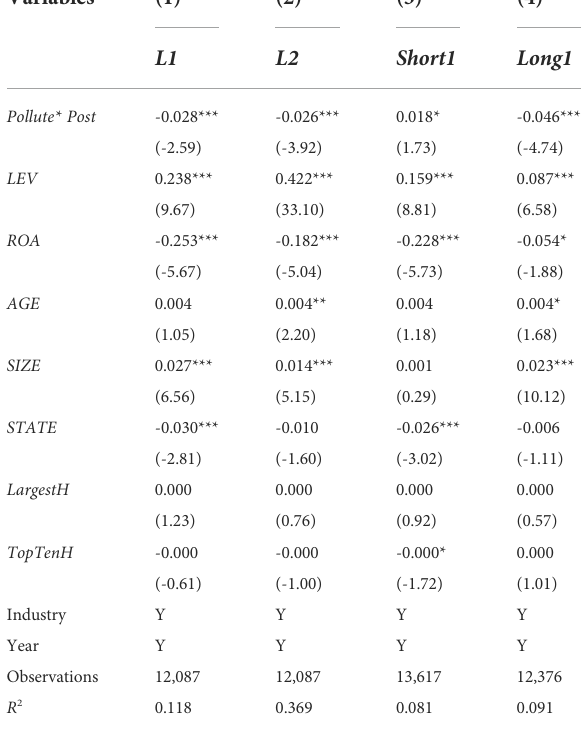
TABLE 7Bootstrap ofgreen credit policy oncorporatedebt fi nancing.